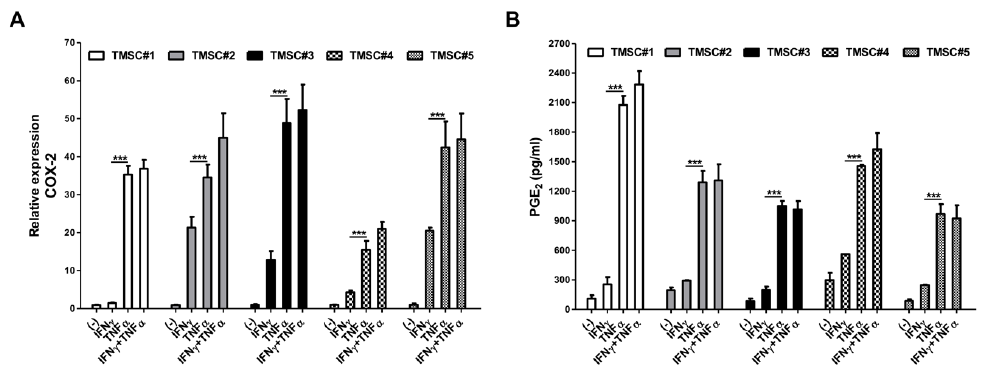
Figure 2. Upregulation of critical immunomodulatory factors in TMSCs by TNF-α priming. TMSCs obtained from five different individuals were primed with 20 ng/mL of IFN-γ or TNF-α or both for 24 h, and ( A ) the level of COX-2 mRNA expression and ( B ) the secretion of PGE 2 in cell culture supernatants were determined by real-time RT-PCR and ELISA, respectively, compared to the naïve TMSCs. All data are shown as mean ± S.D. p -value = *** < 0.001.